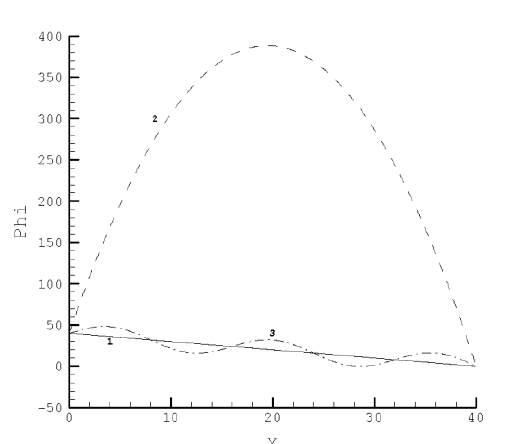
Fig. 3. The final distribution of the electric potential for different types of perturbations with the flow velocity u=0.25 . 1: Electroneutral perturbation; 2: Non-electroneutral constant perturbation; 3: Non-electroneutral sinusoidal